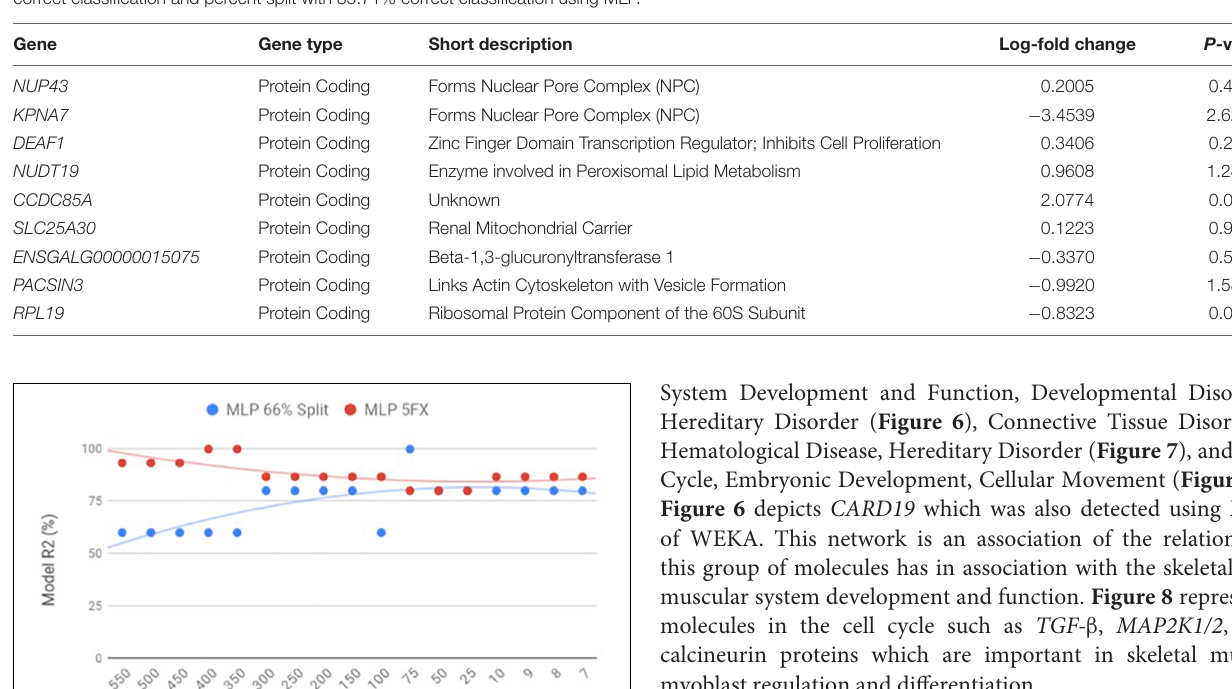
TABLE 2 | Top nine regulators of differential expressed genes in the PM of birds with normal PM compared to severe/moderate WB by 5-fold cross-validation with 100% correct classification and percent split with 85.71% correct classification using MLP.